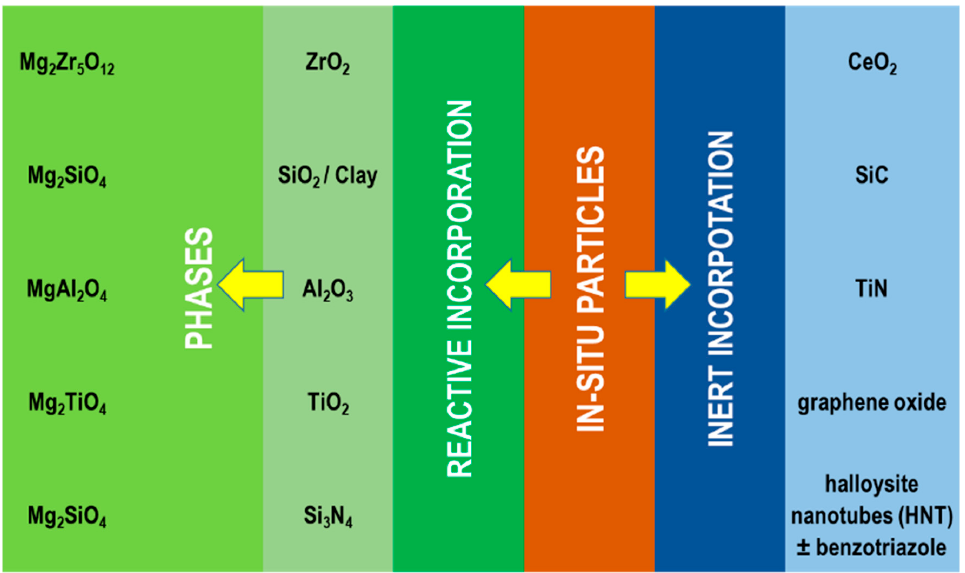
Figure 15. Overview of the insoluble particle types added in situ into the PEO electrolyte and their effect on the formed